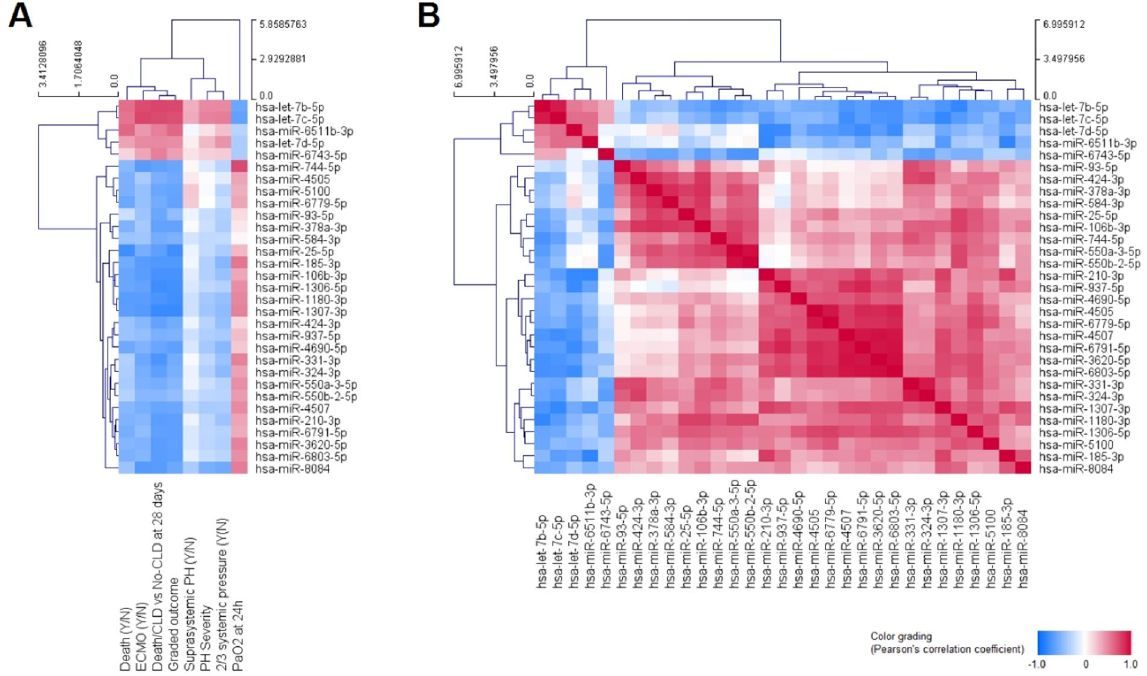
Figure 2. Correlation heatmaps of expression levels of significantly changed miRNAs with clinical classifications/measures (A) and the expression of other miRNAs (B) . Color grading corresponds to the positive (red) and negative (blue) Pearson’s correlation coefficients. Rows and columns were hierarchically clustered by Euclidean distance with complete linkage. Clinical classifications/measures were mostly represented as absent (N = 0) or present (Y = 1), except for the graded outcome (where no-CLD = 0, CLD = 1 and death = 3), PH severity (where mild = 0, moderate = 1 and severe = 3), and the continuous values of PaO 2 at 24